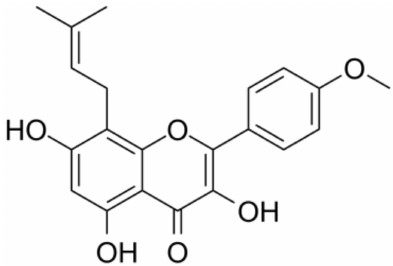
Figure 21. The chemical structure of